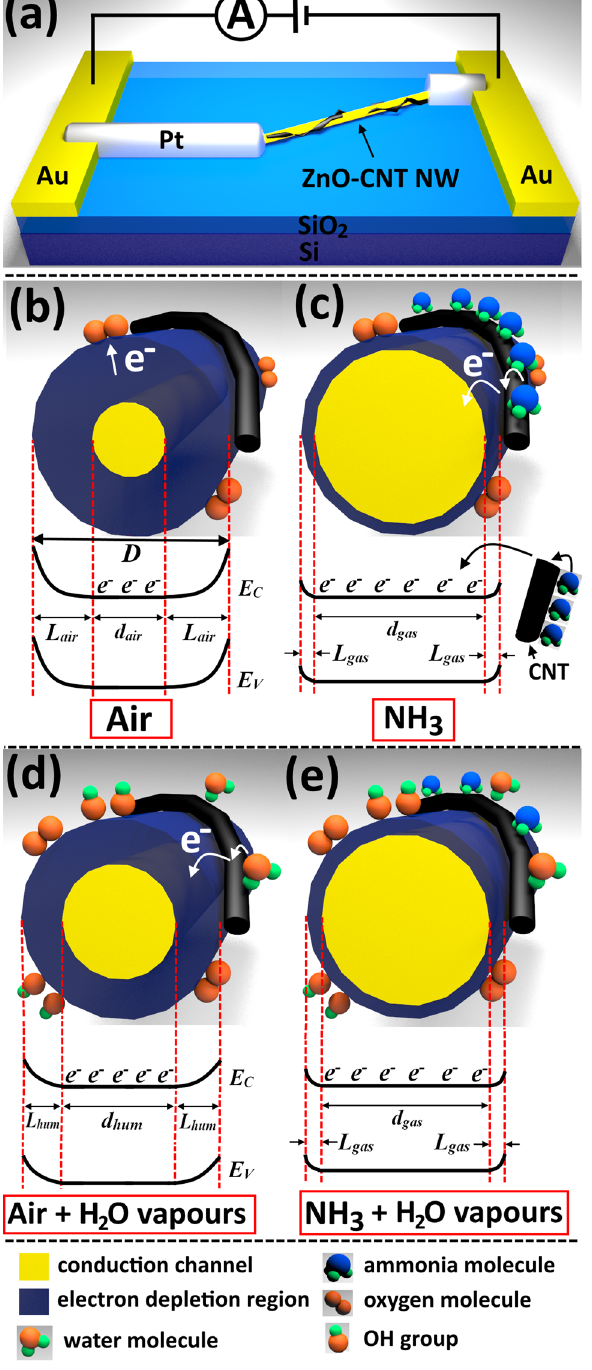
Figure 7. ( a ) Schematic illustration of the nanosensor structure’s based on individual ZnO-CNT NW and the chosen connection for electrical measurements. ( b – e ) Proposed NH 3 sensing mechanism with energy band diagrams at room temperature of individual ZnO-CNT NW without taking into account the oxidation of NH 3 molecules by oxygen species. ( b ) Exposure under ambinet air by ionization of oxygen molecules at surface of the NW and formation of the electron depletion region with width L air . The width of conduction channel was noted as d air . ( c ) Exposure under ammonia by adsorption of NH 3 molecules on the surface of CNT and subsequent electron transfer to ZnO NW, leading to a narrowing of the electron depletion region ( L gas ) and widenning of the conduction channel ( d gas ). ( d ) Exposure under air with high concentration of water vapours. Water molecules adsorb on the surface of ZnO forming OH groups and on the surface of CNTs. Both reactions have donor effect, leading to a narrowing of the electron depletion region ( L hum ) and widenning of the conduction channel ( d hum ). ( e ) Exposure under NH 3 molecules and high concentration of water vapours, leading to practically the same results as in the case of ( c